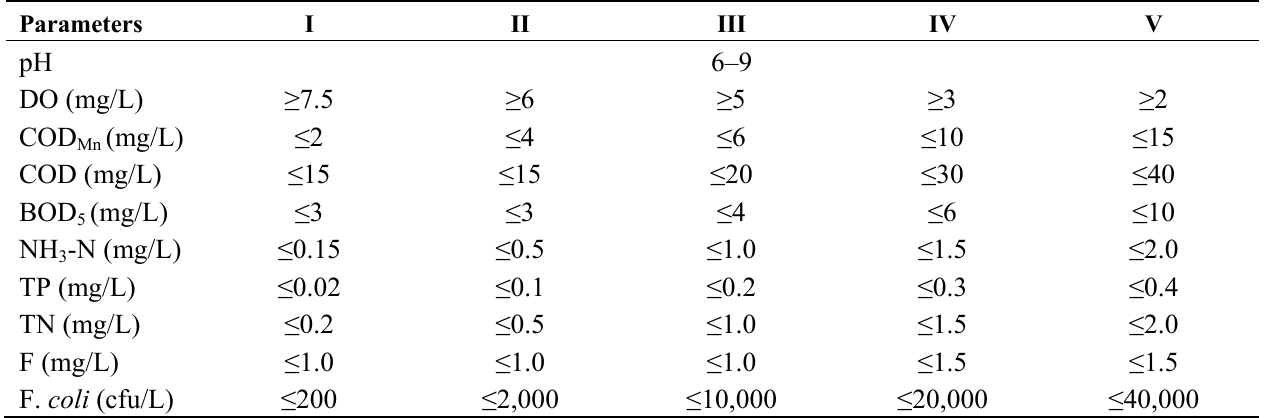
Table 1. Environmental Quality Standards for Surface Water of China.